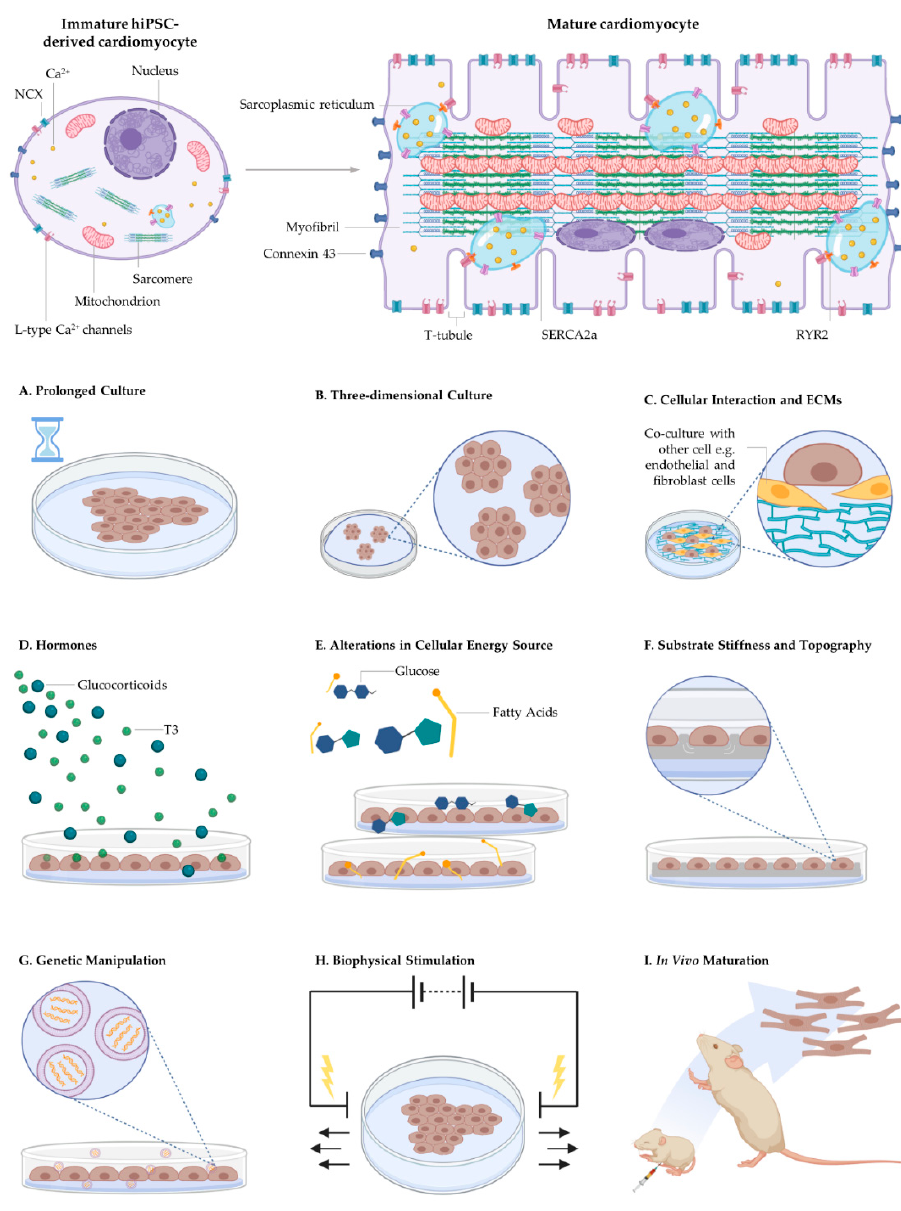
Figure 4. Engineered microenvironments used to augment the maturity of human-induced plu- ripotent stem cell-derived cardiomyocytes. Current strategies include ( A ) prolonged culture pe- riod, ( B ) three-dimensional culture periods, ( C ) co-culture with fibroblasts, endothelial cells and ECMs, and biochemical factors such as ( D ) hormones including glucocorticoids and T3 and ( E ) fatty acids rather than glucose for energy production. Approaches also include ( F ) substrate stiff- ness and topography, ( G ) genetic manipulation, ( H ) biophysical stimulation including mechanical and electrical stimulation and ( I ) in vivo maturation. However, the mechanisms by which these signals drive cardiomyocyte maturation remain largely